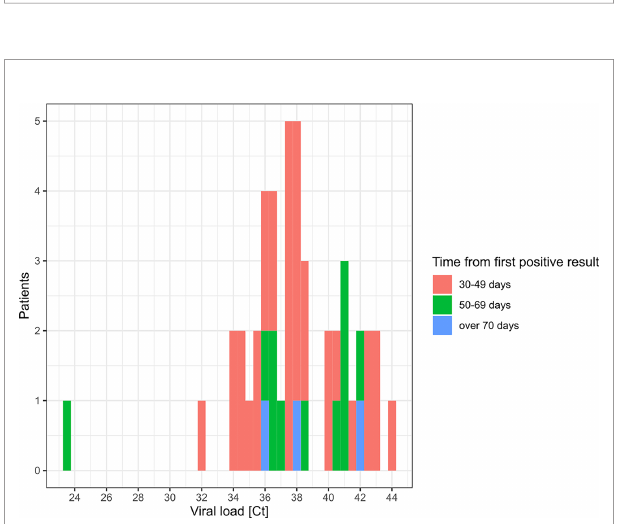
FIGURE 4 | Time interval between successive concordant analyzes from the same patient. Distribution of 4,366 pairwise concordant comparisons according to time interval between their reception dates. Negative concordant comparisons for SARS-CoV-2 detection (n = 4,116) (A) . Positive concordant comparisons for SARS-CoV-2 detection (n = 250) (B) .